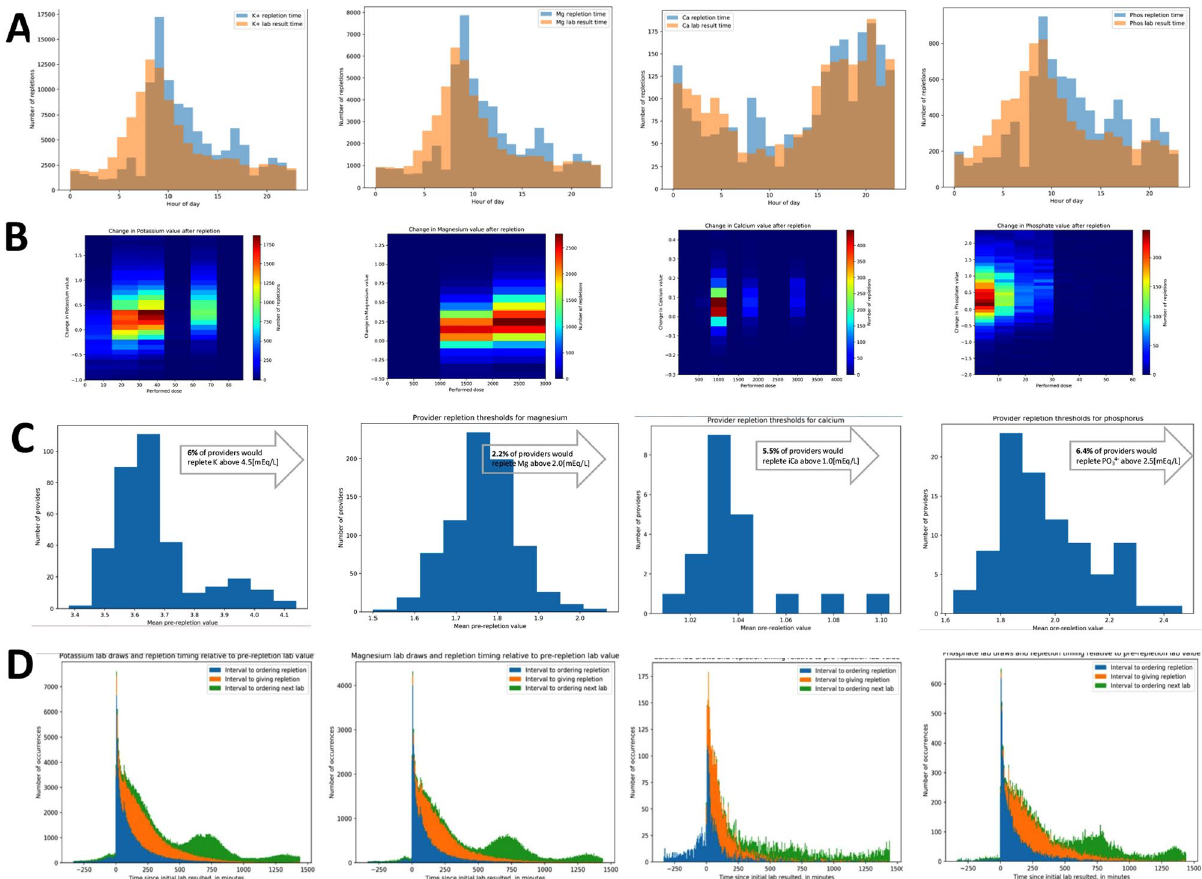
Figure 2. Behavioural patterns of electrolyte replacement. Majority of lab values for potassium, magnesium, and phosphate were reported in the morning with replacement orders being placed in the morning (majority) and afternoon (a significant minority) ( A ). The increased dose of electrolytes resulted only in a modest increase in post-repletion values ( B ). Small yet significant number of providers repleted electrolyte above the reference levels ( C ). The replacement timelines revealed significant overlap between placement of the order for replacement and ordering follow-up lab ( D ).